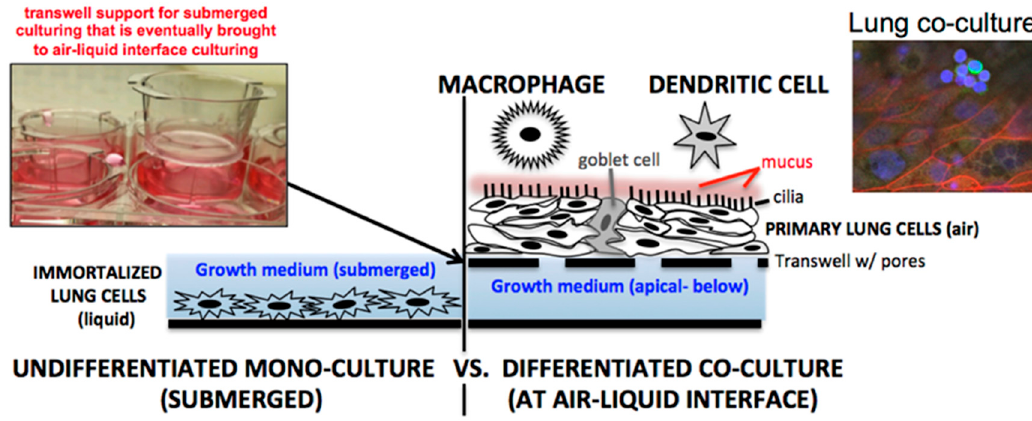
Figure 1. Lung cell culturing through either ( left ) submerging cells in liquid culture medium or ( right ) culturing cells at air-liquid-interface on transwell supports. Additional complexity can be integrated by co-culturing immune cells on the apical lung cell surface. Shown on the right is a cluster of monocyte-derived macrophages (green—CD14+) placed above lung epithelial cells (red—actin).